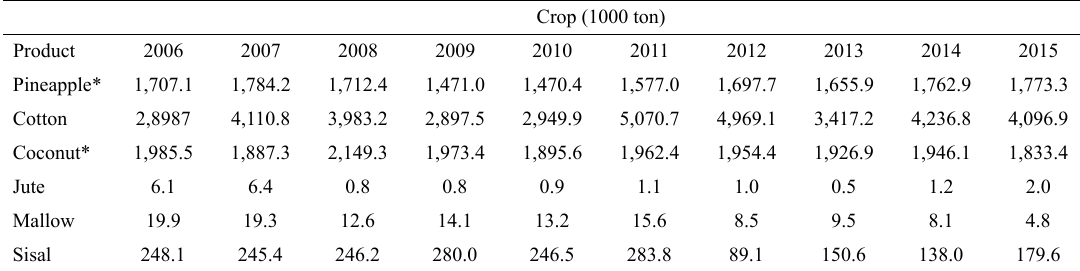
Table 1. Brazilian crop of natural fiber containing products from 2006 to 2015 28 .